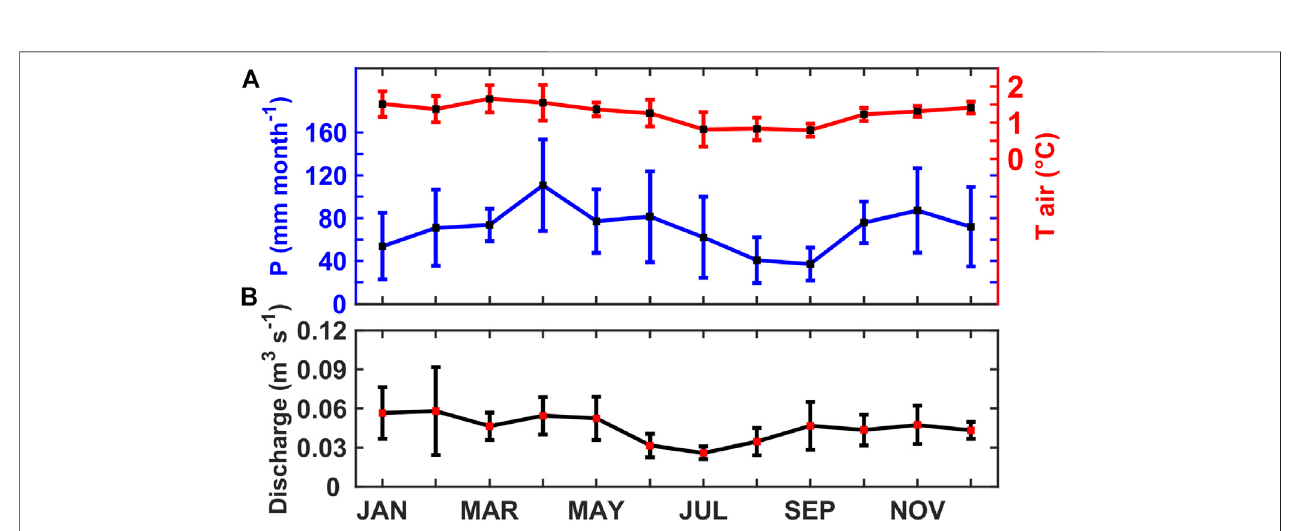
FIGURE2|(A) Monthlyprecipitationvalues(blueline)measuredatP8raingaugebetween2005and2015,verticalbarsrepresentmonthlystandarddeviation.The sameforairtemperature(redline)measuredatSAMA-1between2011and2015. (B) Meanmonthlydischargemeasured(blackline)inLosCresposhydrologicalstation measurements between 2004 and 2014. Only months with data for more than 80% of the time steps were considered for cycles.